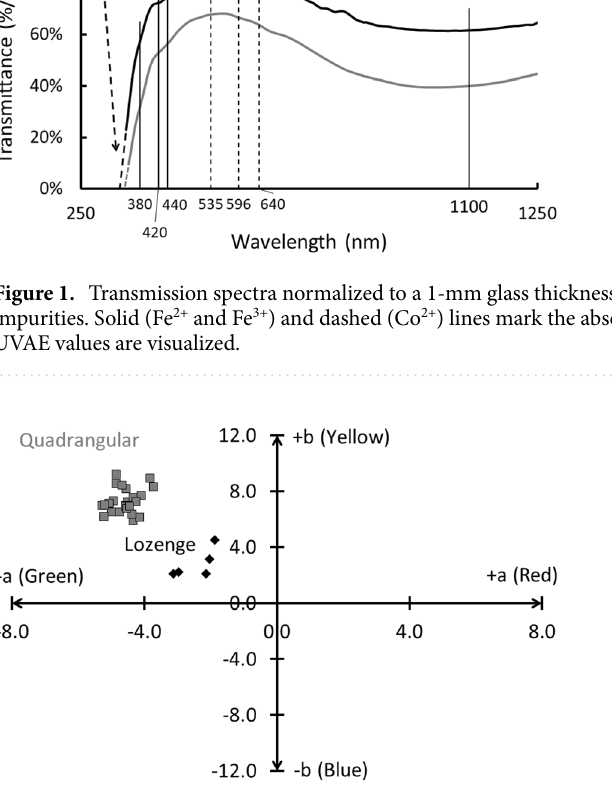
Figure 2. The paler appearance and purer character of the lozenge glass (filled diamond) compared to the quadrangular glass (filled square) is proven by its CIELab colour values, which are closer positioned to the origin of the